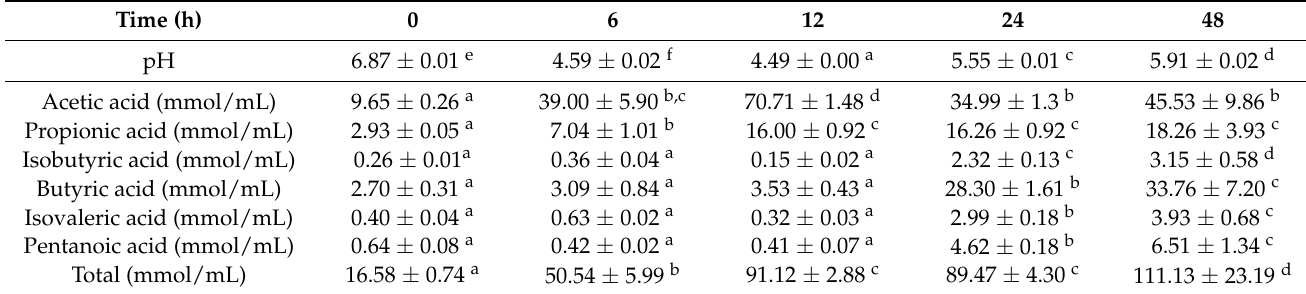
Table 2. Changes in pH and SCFAs in fermented cultures that were supplemented with HLP at different times during in vitro